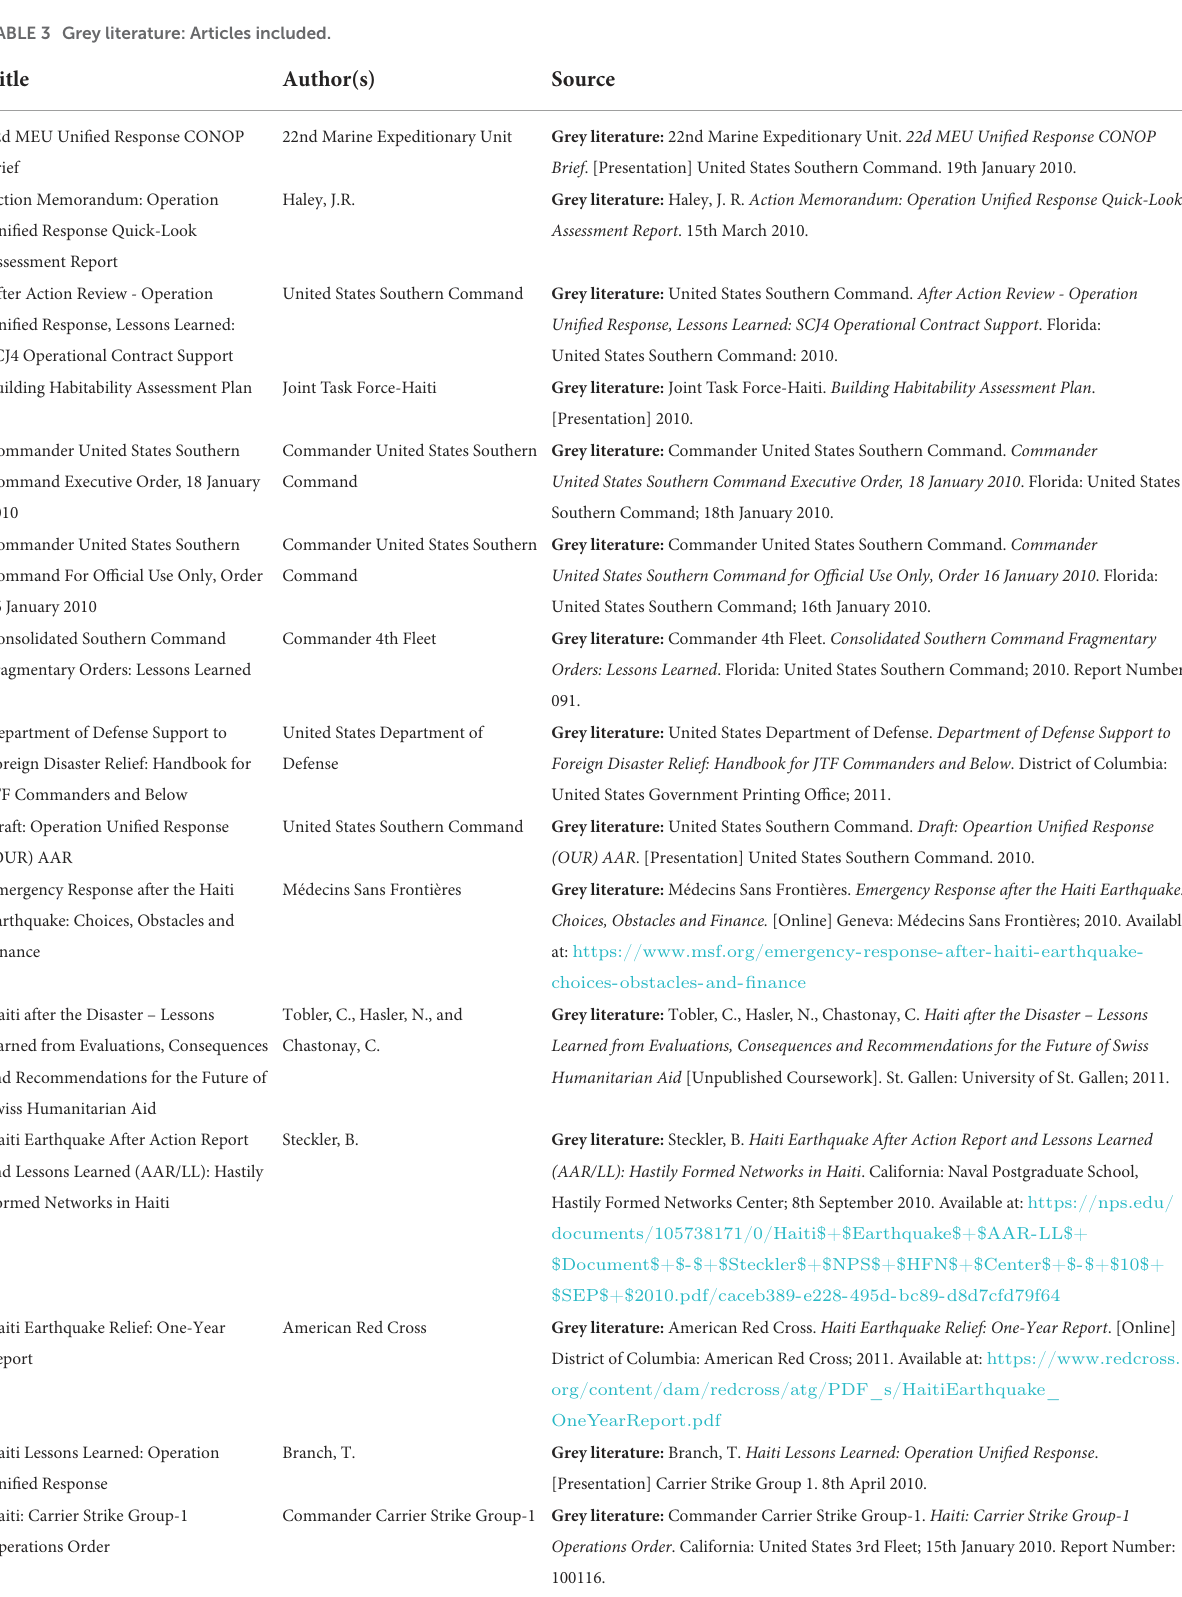
TABLE 3 Grey literature: Articles